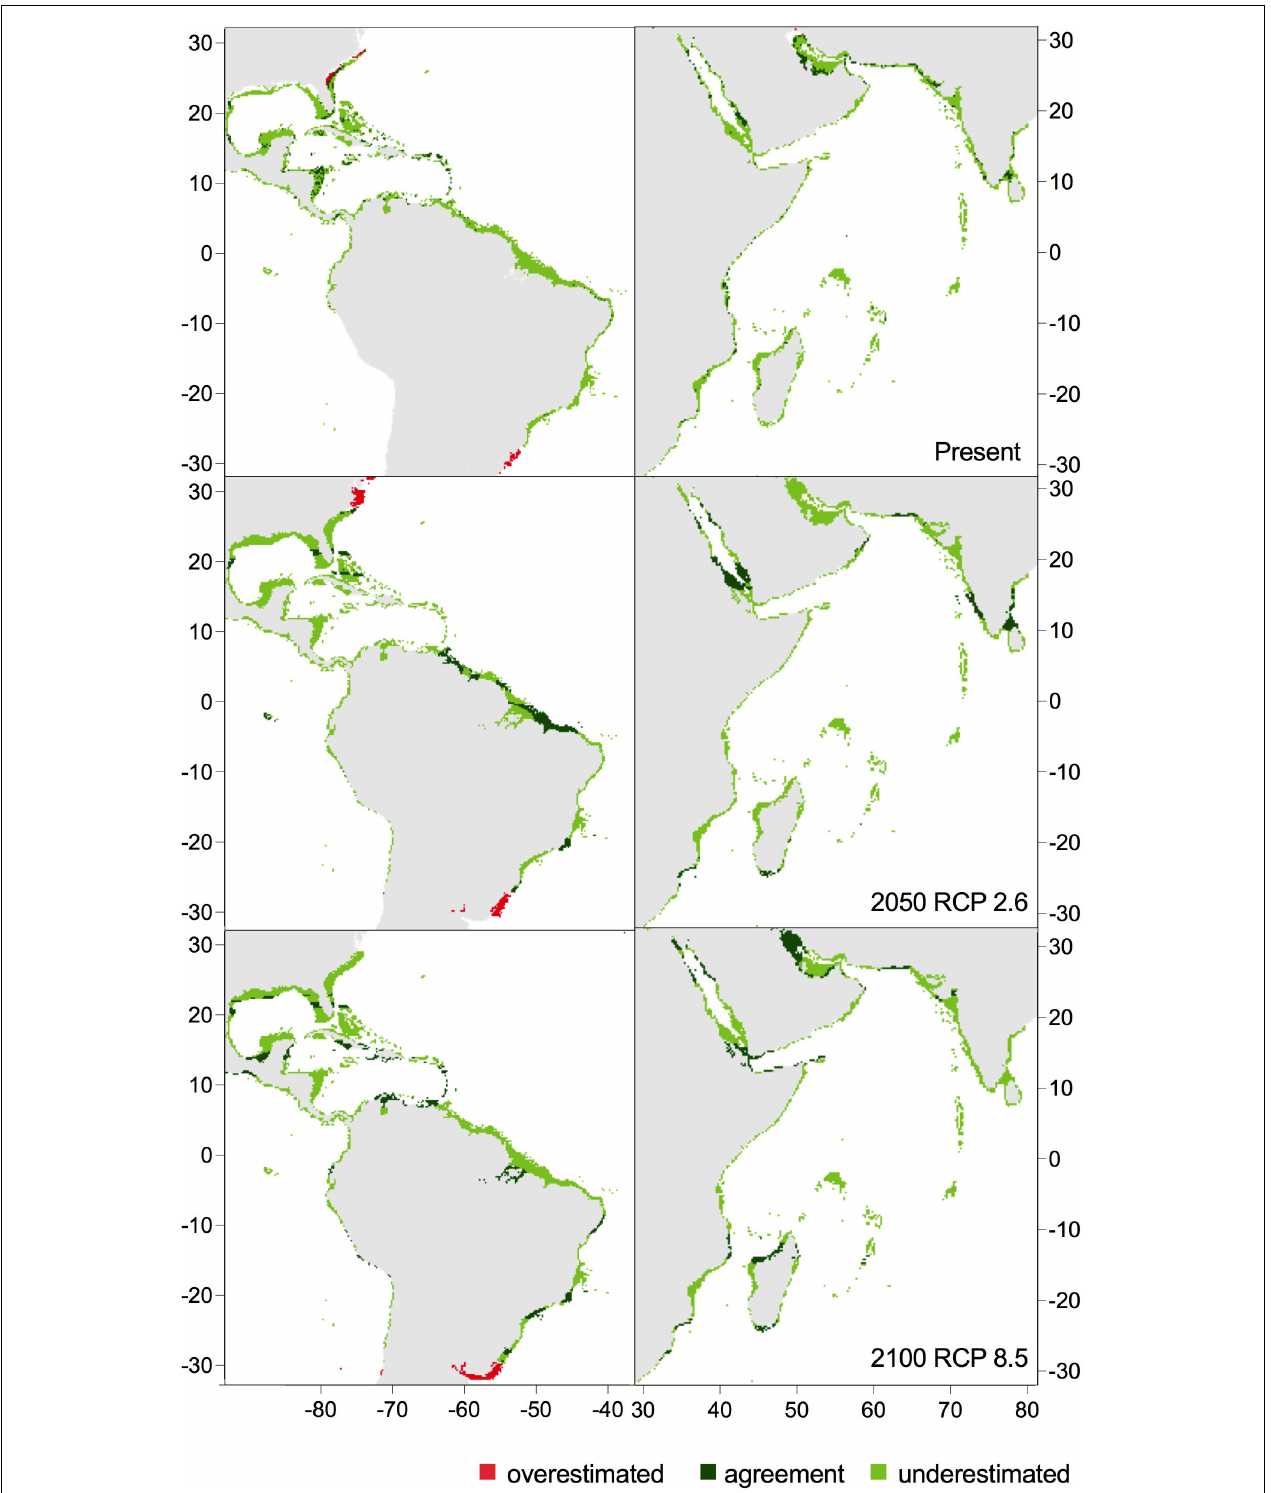
FIGURE 4 | Predicted occurrence of Halophila stipulacea according to the hybrid model 1 (based on native Red Sea thermal limits considering niche conservatism; 17–36 ◦ C) under present conditions and 2 different climate change scenarios in the native range in the Indian Ocean and Red Sea (on the right) and in the exotic range in the Caribbean Sea (on the